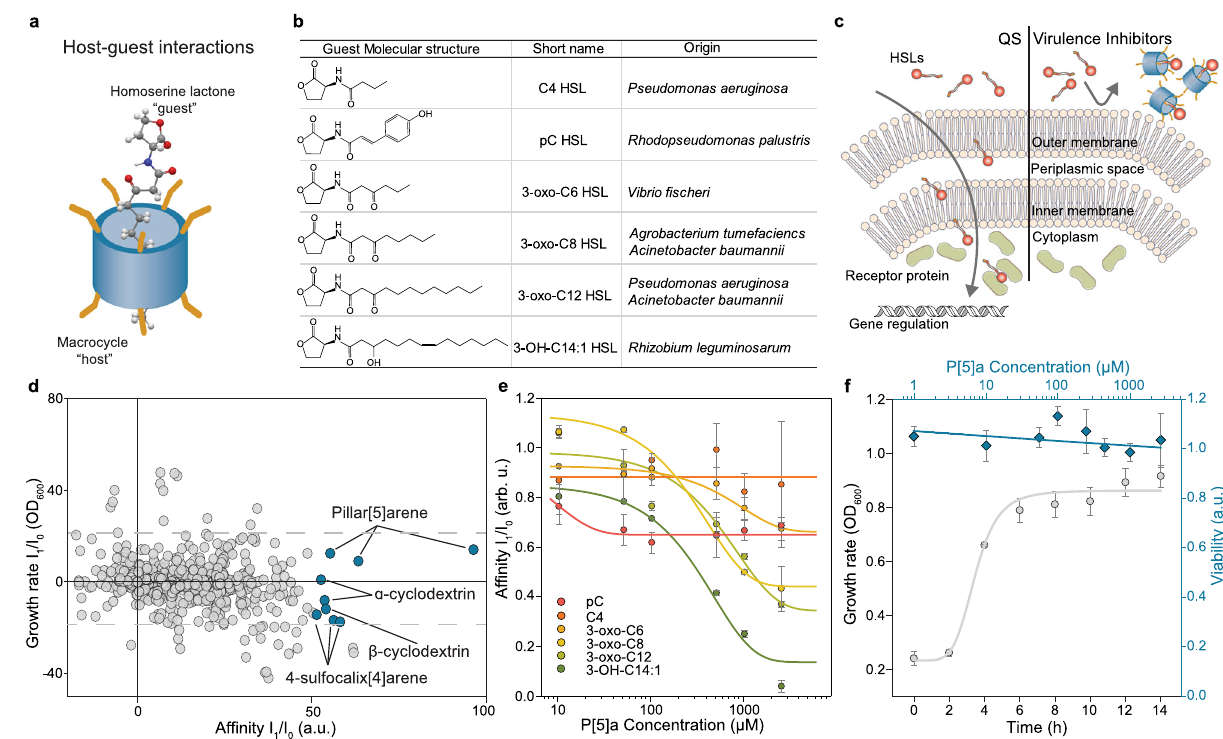
Fig.1|Host-guestinteractionsbetweenmacrocyclesandbacterialhomoserine lactones selective for HSLs with prolonged acyl chains. a Schematic of the interaction between macrocyclic “ hosts ” with HSL “ guests ” . b The molecular structures, abbreviated names and bacterial species of all QS HSLs used in this study. c Schematic representation of HSL quorum sensing in Gram-negative bac- teria (left), along with a virulence inhibition approach (right). In short, HSLs pro- duced by select individuals diffuse freely through the outer and inner membranes and get sensed by intracellular receptor proteins in other community members, promoting the production of isogenic HSL and a synchronized regulation of activities. Applied virulence inhibition strategy, where the interaction between the HSLs and macrocyclic host prevents the recognition of HSLs by its cognate receptor. d Screening for the interaction between HSLs as seen in ( b ) and a set of macrocyclesrevealsseveralcombinationswherethe macrocycleinteracts withthe HSL and where the growth rate in E. coli (I 1 /I 0 OD 600 ) remains mostly unaffected